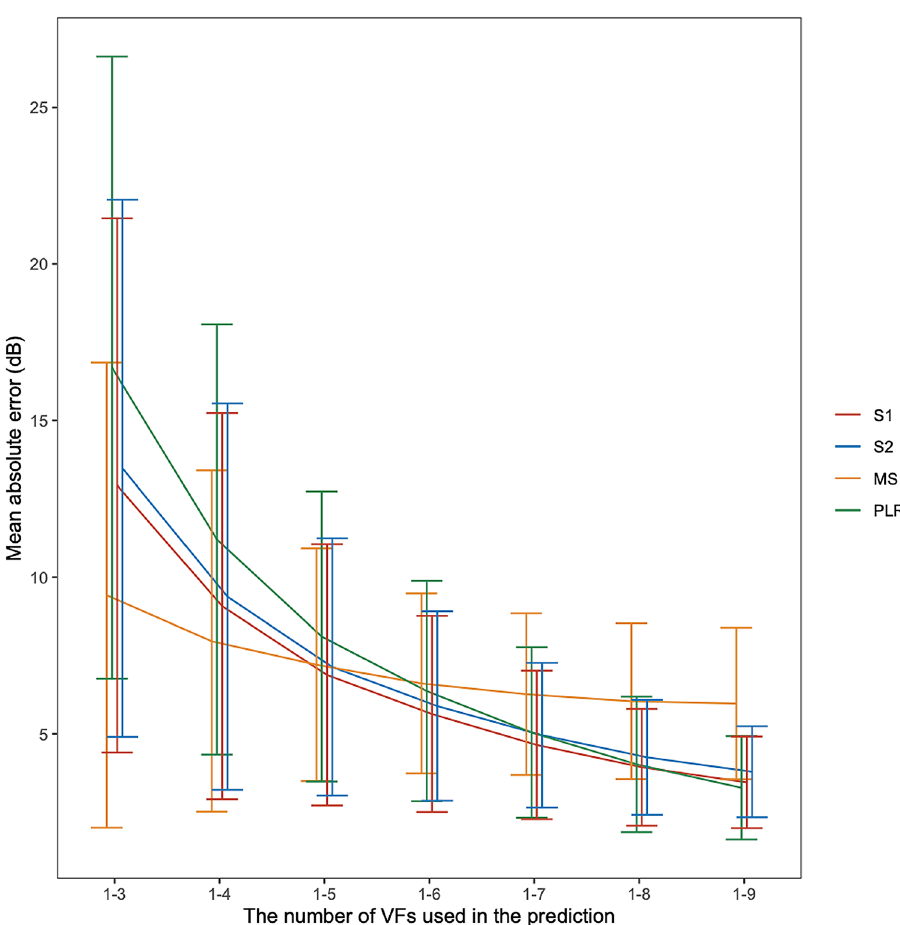
Figure 2. Mean absolute error when predicting the 10th VF. MAE values associated with sector-wise regression (S1 mapping) were significantly smaller than those with PLR, when the first three to first seven VFs were used, and significantly smaller than those with the S2 mapping when the first six to first nine VFs were used. Data are expressed as mean ± SD.